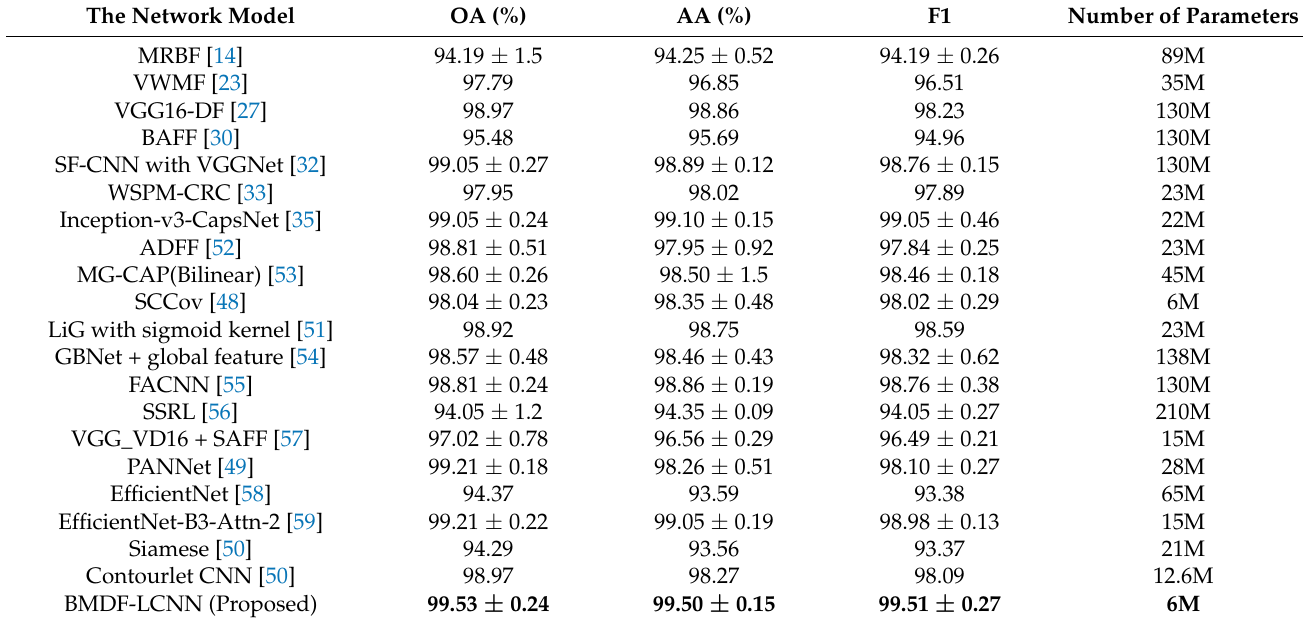
Table 2. Performance comparison of the proposed model with some state-of-the-art methods on UC Dataset. The Network Model